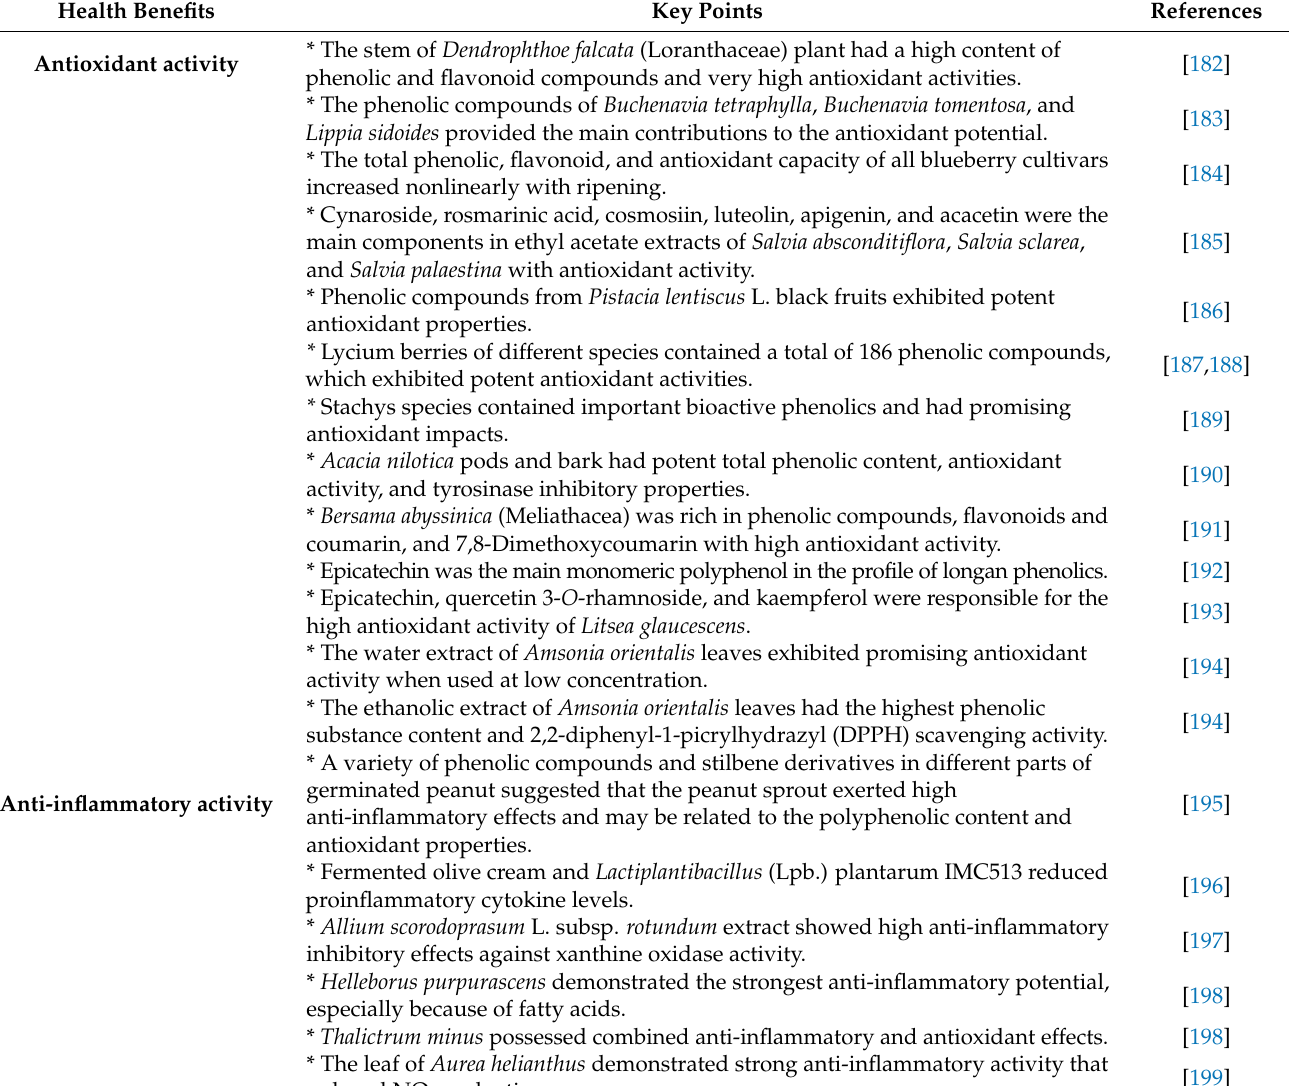
Table 5. Biological activities of phenolic